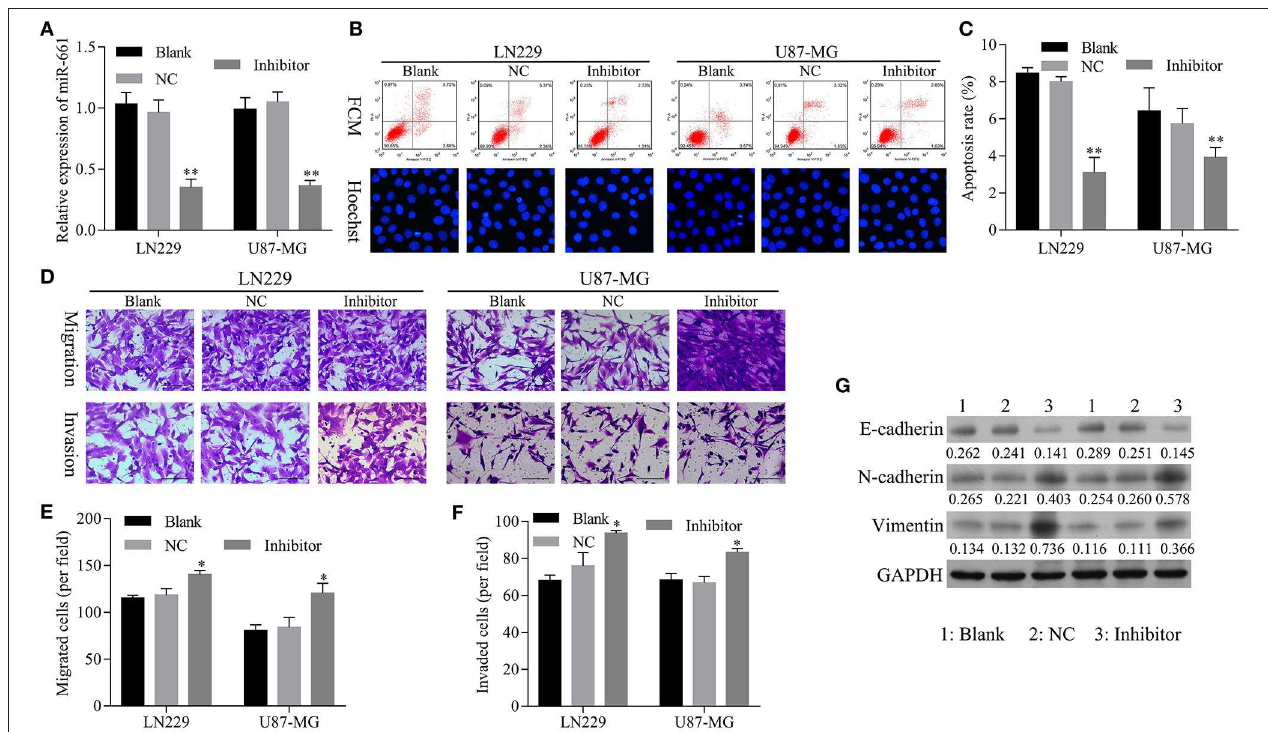
FIGURE 5 | Transfection with an miR-661 inhibitor suppressed glioma cell apoptosis and induced cell migration and invasion. (A) qRT-PCR assays were performed to detect miR-661 expression. (B,C) Flow cytometry and Hoechst 33258 staining were used to detect cell apoptosis. (D–F) The effect of miR-661 knockdown on cell migration and invasion was evaluated by Transwell assays. (G) The expression of EMT-related proteins (E-cadherin, N-cadherin, and vimentin) was examined by western blot assays (* P < 0.05, ** P < 0.01). NC: negative control, Inhibitor: miR-661